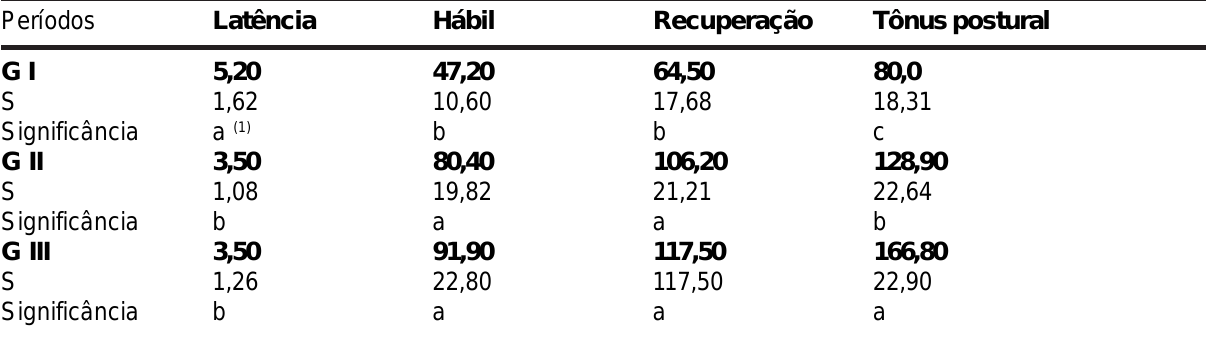
TABELA 3 - Valores médios e desvios-padrão referentes ao período de latência, (PL) hábil anestésico (PHA) recuperação